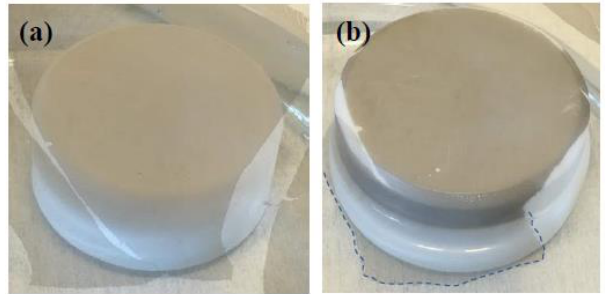
Figure 3. ( a ) The dense MGFs floating on a water surface above the PTFE sample with a diameter of 4.1 cm; ( b ) MGFs settles down on the Teflon surface while lowering the water level (the dashed line shows the boundary of MGFs and SDS molecules).